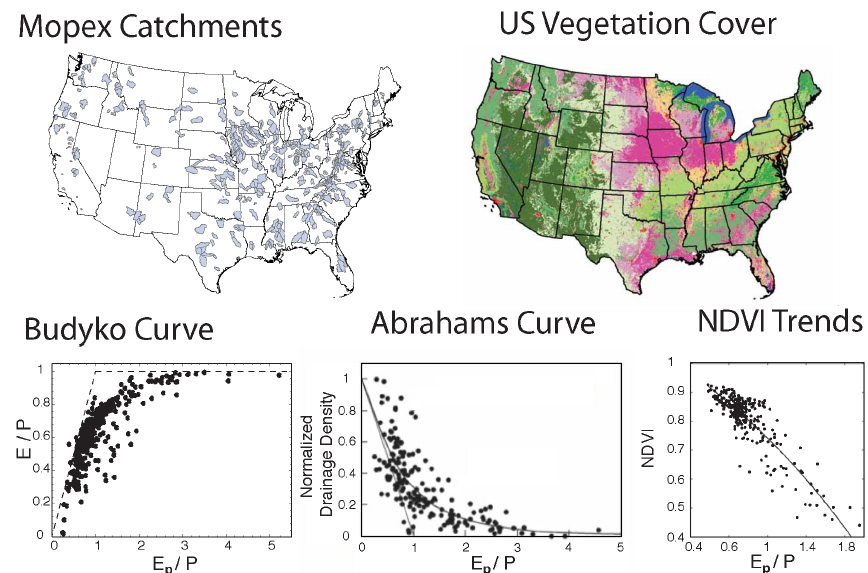
Fig. 5. Illustration of three studies in comparative hydrology: Budyko’s curve provides constraints on the hydroclimatic regime of individual catchments with a typical relationship emerging between aridity (potential evaporation normalized by precipitation) and the catchment evaporative fraction. Here it is reproduced from data from 430 MOPEX catchments across the USA (Budyko and Miller, 1974; Duan et al., 2006). Abrahams curve indicates a typical relationship between the drainage density in a catchment and aridity, here again MOPEX data have been used to derive the curve (Wang and Wu, 2013). Finally, vegetation greenness, as measured by NDVI, also follows characteristic patterns with aridity (Voepel et al.,